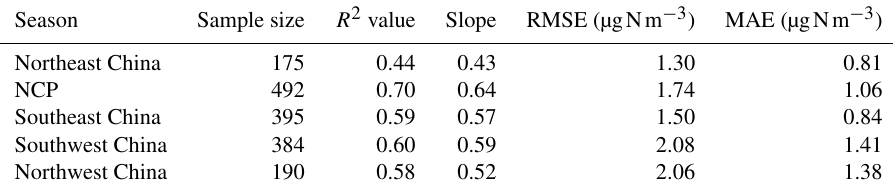
− estimation over China in different regions (northeast China includes Heilongjiang, Jilin, and Table 3. The cross-validation result of NO 3 Liaoning provinces; NCP includes Beijing, Tianjin, Hebei, Henan, Shandong, and Shanxi provinces; southeast China includes Jiangsu, Zhejiang, Fujian, Guangdong, Jiangxi, Anhui, Hunan, Hainan, Shanghai, and Hubei provinces; southwest China includes Yunnan, Guangxi, Sichuan, Tibet, Chongqing, and Guizhou provinces; northwest China includes Inner Mongolia, Xinjiang, Gansu, Qinghai, Ningxia, and Shaanxi.